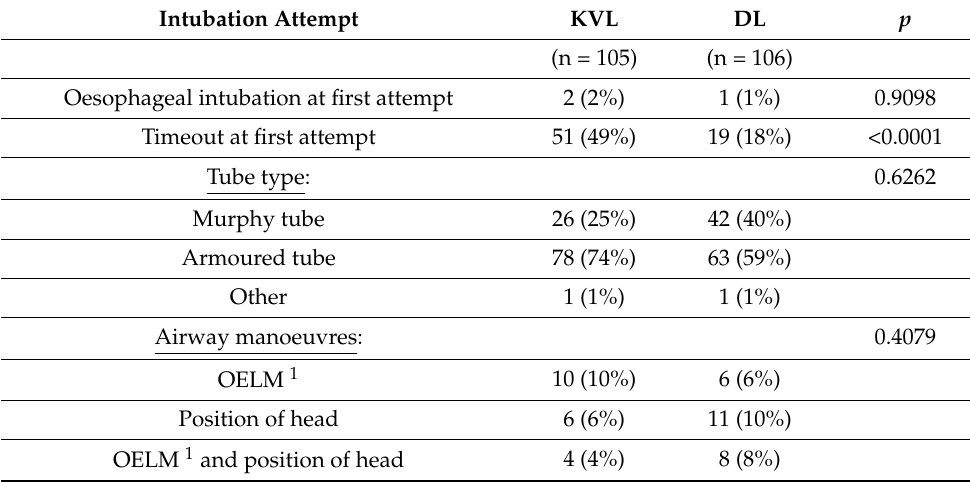
Table 2. Characteristics of the intubation attempt in the King Vision™ Paediatric aBlade™ video laryngoscope (KVL) and conventional direct laryngoscopy (DL) group. Values are numbers (proportion).